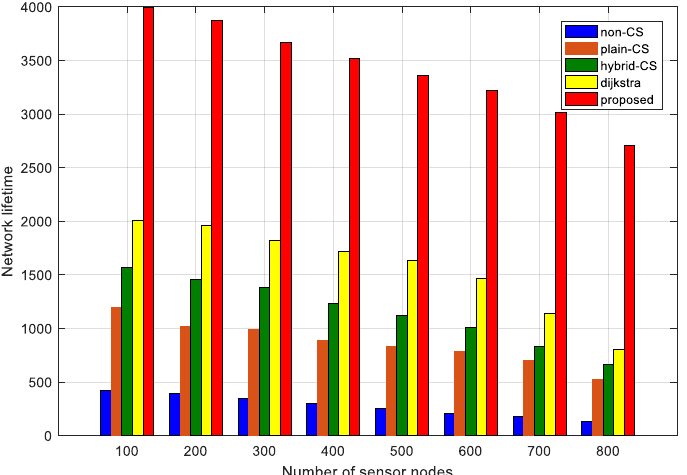
Figure 18. Network lifetime compassion of different data-gathering schemes vs. number of sensor nodes.